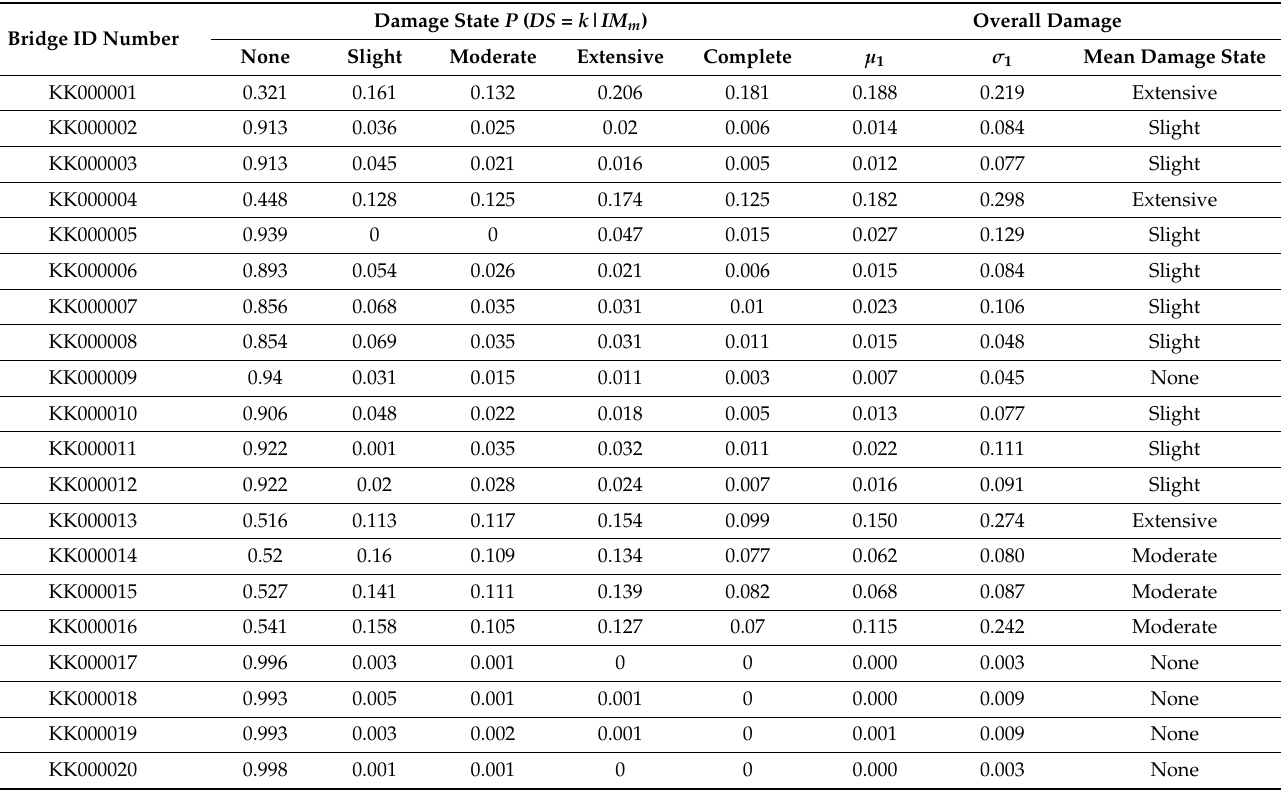
Table 7. Damage state distribution for Scenario